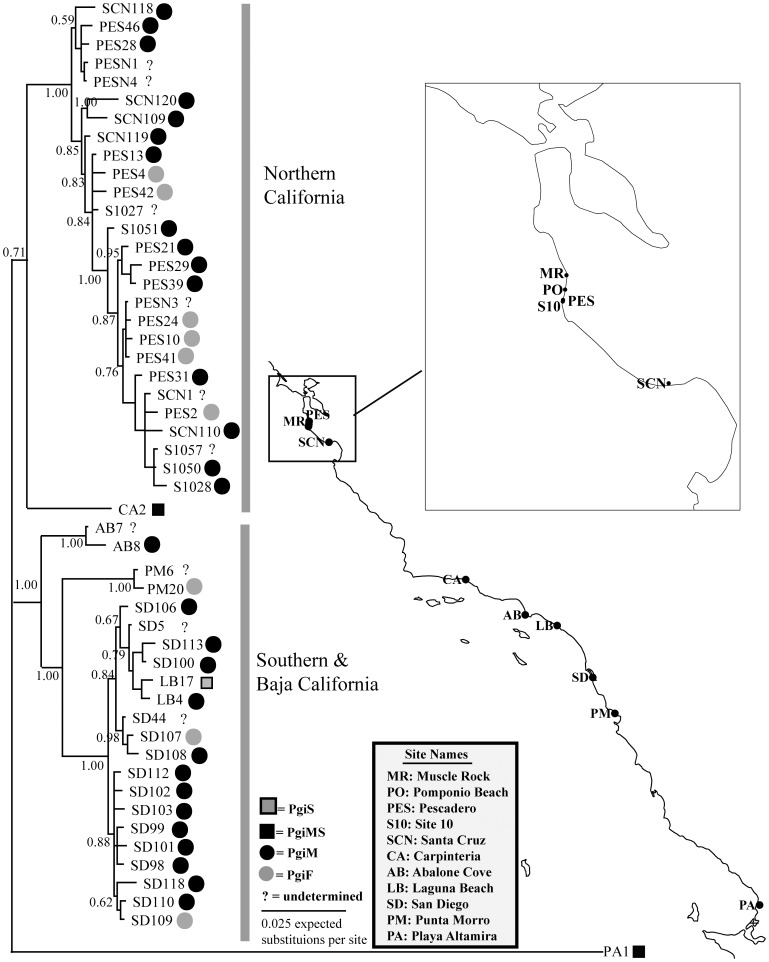
Bayesian majority-rule consensus phylogeny of Pgi.Sequences are labeled according to sample site, individual number, and allozyme class (slow, medium-slow, medium, fast denoted by the colored shapes).